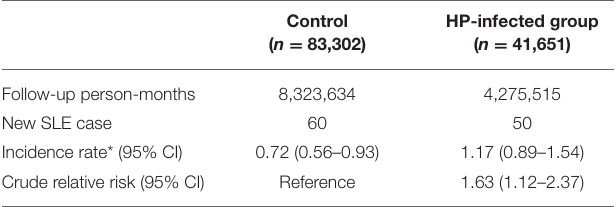
TABLE 1 | Baseline characteristics of study groups after propensity score matching.